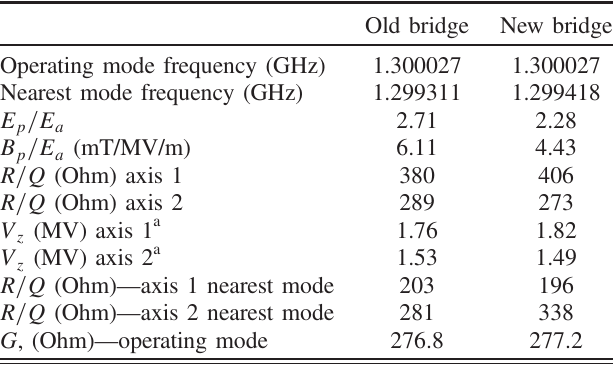
TABLE I. Comparison of the parameters of the T and L þ T cavity with the original and the new coupling